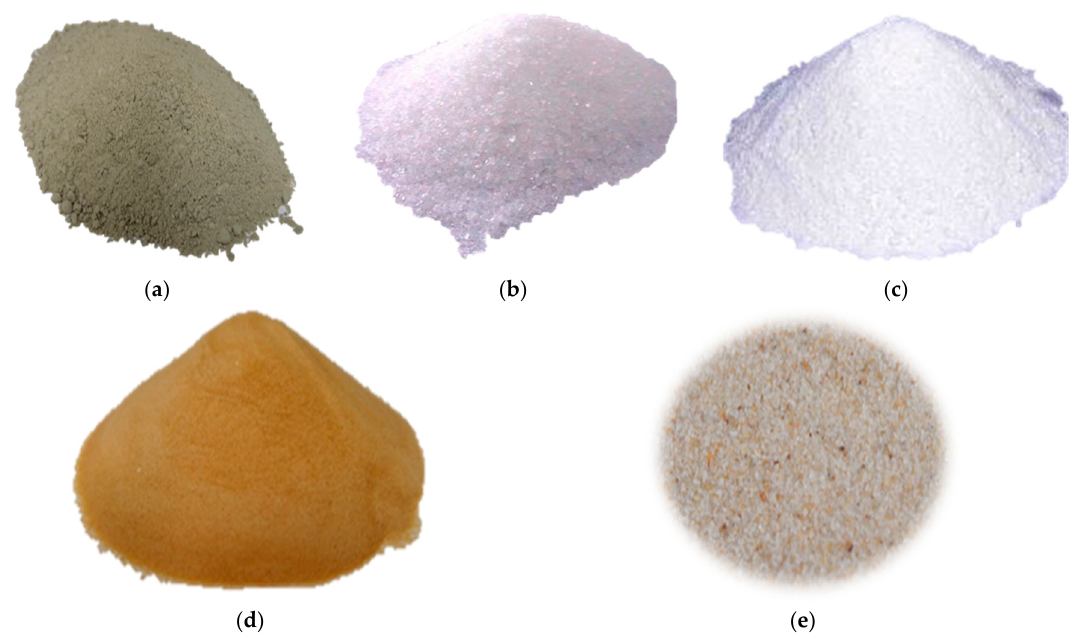
Figure 1. The raw materials: ( a ) cement blend; ( b ) citric acid; ( c ) zinc acetate; ( d ) redispersible polymer powder; and ( e ) quartz sand.